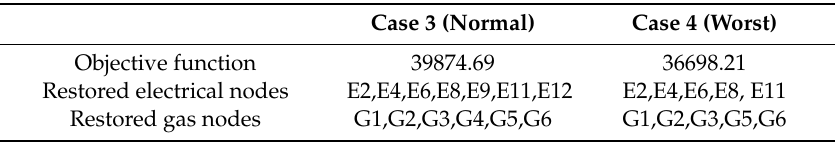
Table 10. The restoration results under normal and worst scenario with deterministic model.